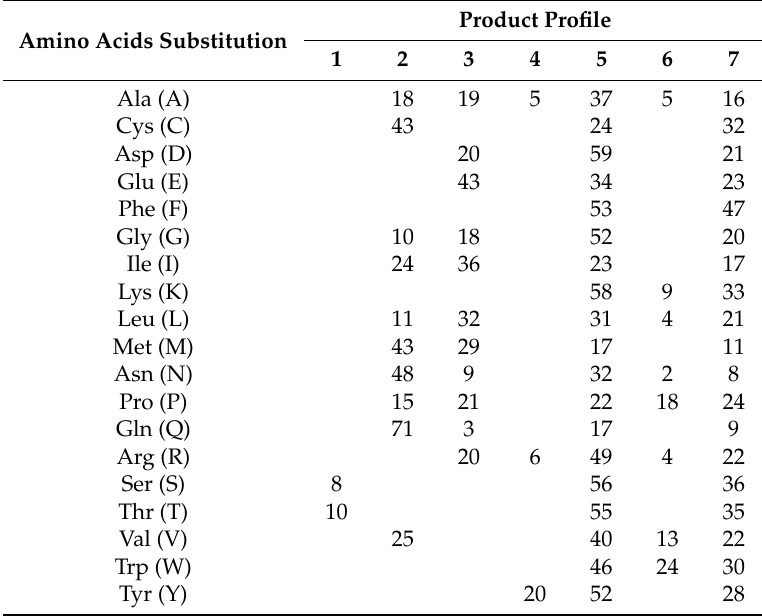
Table 1. Product profile of S. cerevisiae BY4742 expressing the SgCS H260X site-saturated mutants. Amino Acids